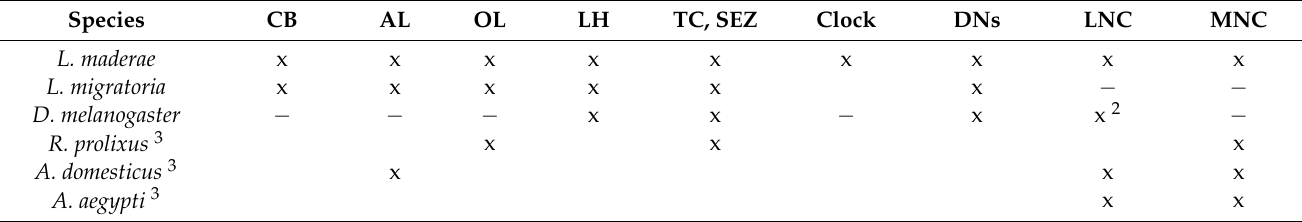
Table 1. Distribution of LK neurons in the brain of representative insects